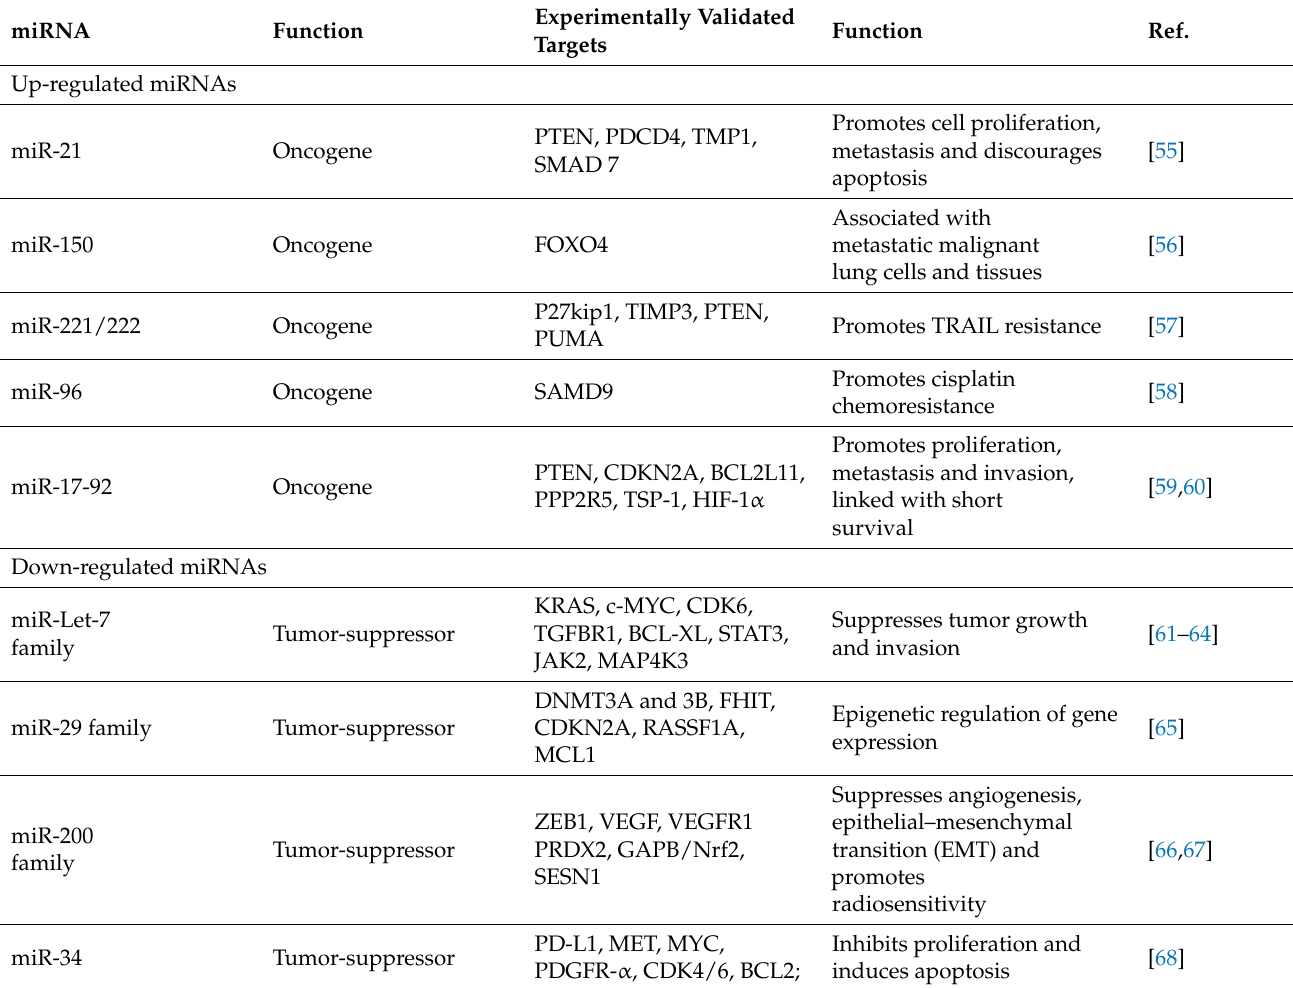
Table 2. Most studied miRNAs over-expressed or downregulated in